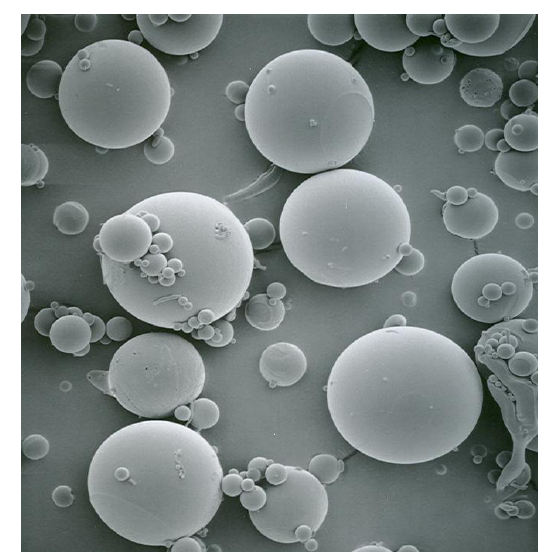
Figure 2: Scanning electron microscopy of KSL peptide loaded AcHES- RG503 microspheres.